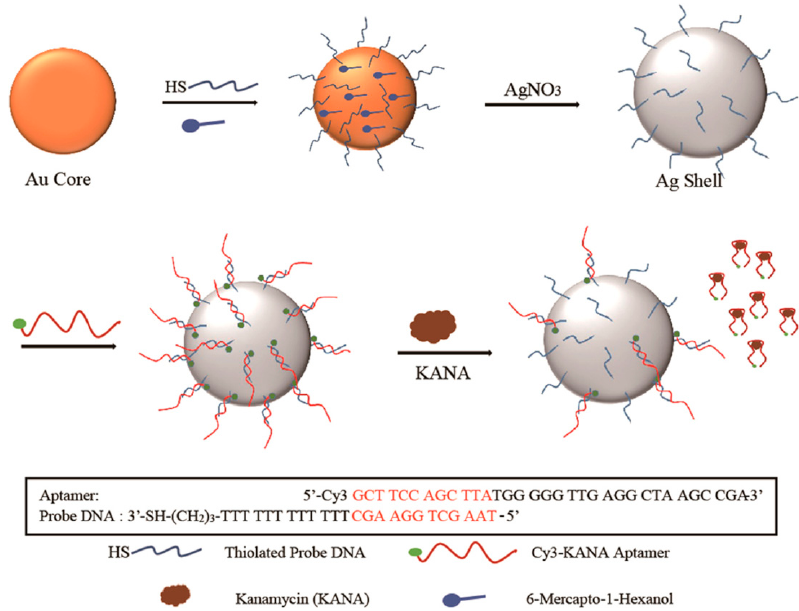
Figure 12. Schematic diagram of the SERS-based method for kanamycin (KANA) detection by using double-strand DNA aptamer-bonding Au@Ag NP. (Reprinted with permission from Elsevier, 2019 [79]).